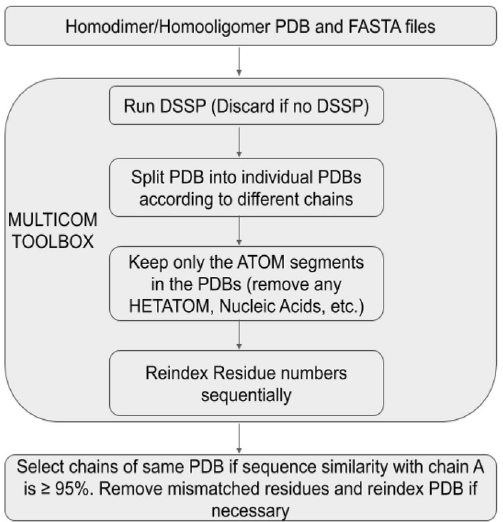
Figure 1. Diagram describing how the input PDB file was pre-processed using the MULTICOM TOOLBOX to clean up the PDB files. If no DSSP is available, the PDB was removed from our list. The individual chains in the multimer PDB were separated into individual files containing the ATOM (x, y, and z coordinates) segments only while discarding all other information. Only chain pairs whose FASTA sequences match 95% or more were kept, and any mismatched residues were removed to ensure homogeneity between